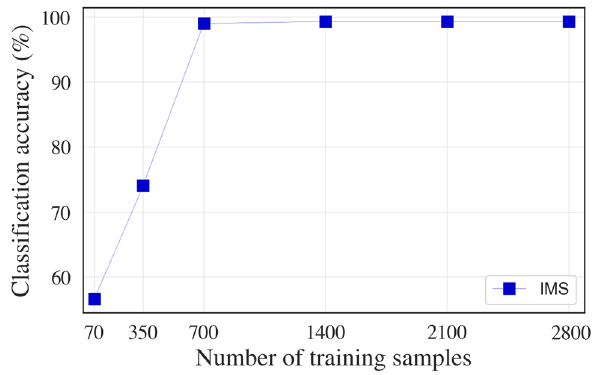
Figure 4. Classification accuracy of TL-CNNs (trained on CWRU, followed by re-training and testing on IMS) for the various number of training samples from the target domain used for retraining the convolutional layers.